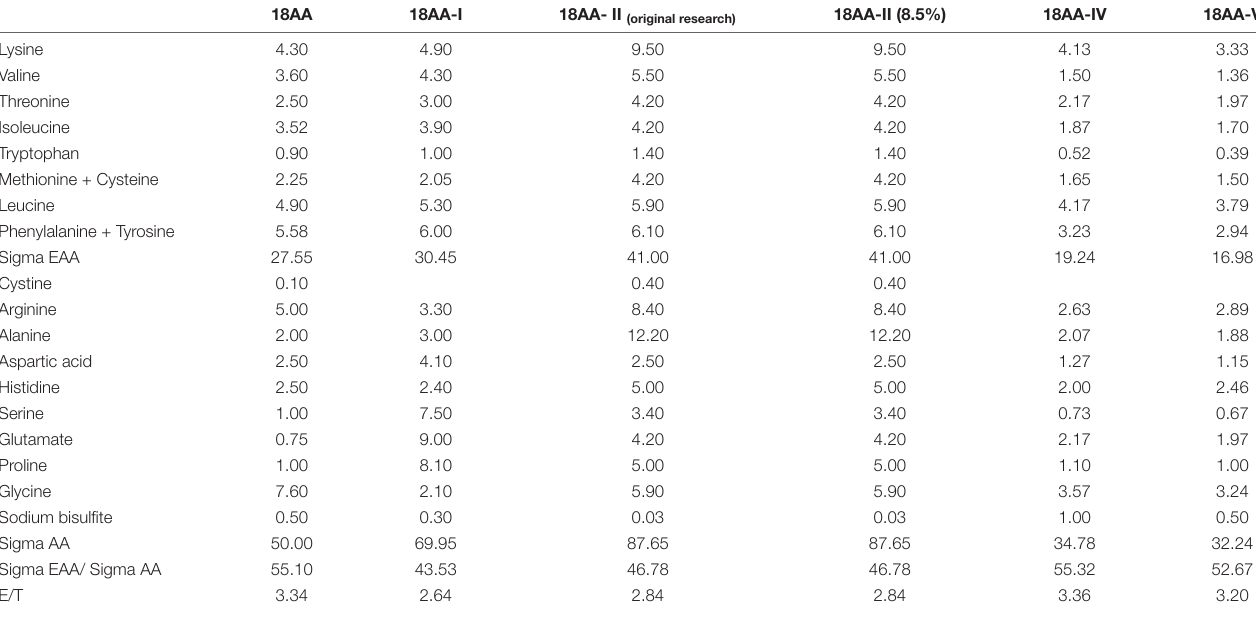
TABLE 2 | Composition, EAA as a percentage of the total AA and the E/T ratio of 18AA-II original research and five formulations of amino acids for